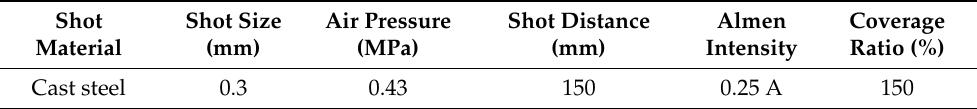
Table 2. Shot peening